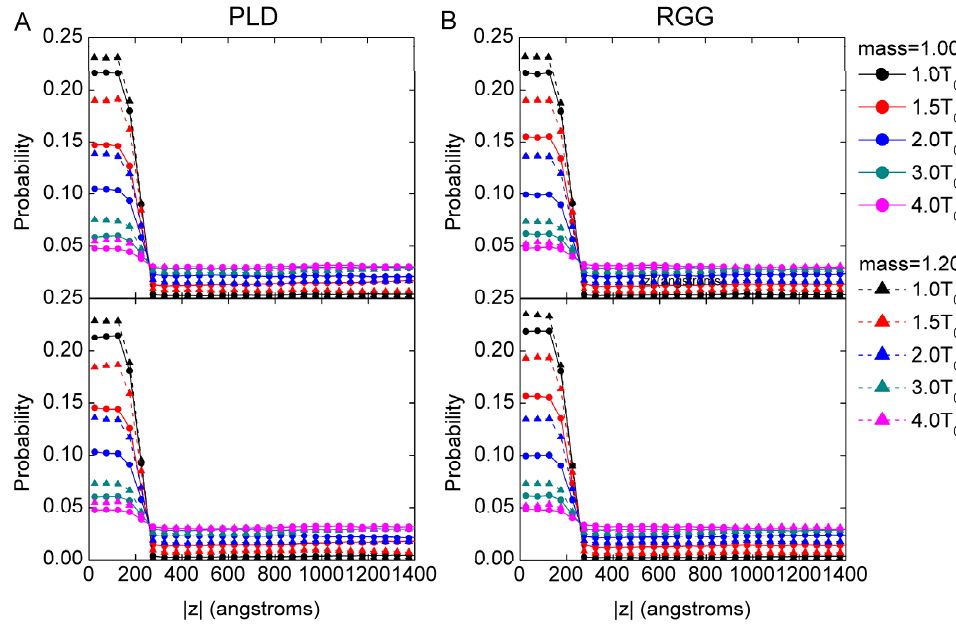
Figure 7. The distribution of probability of PLD ( A ) and RGG ( B ) with bead mass 1.0 and 1.2 as a function of displacement |z|. Data without charges and at 10 mM salt concentration solvent are shown in the upper panels and the bottom panels, respectively. The probability is the average value of window along |z| during the last 1000 τ simulation data.